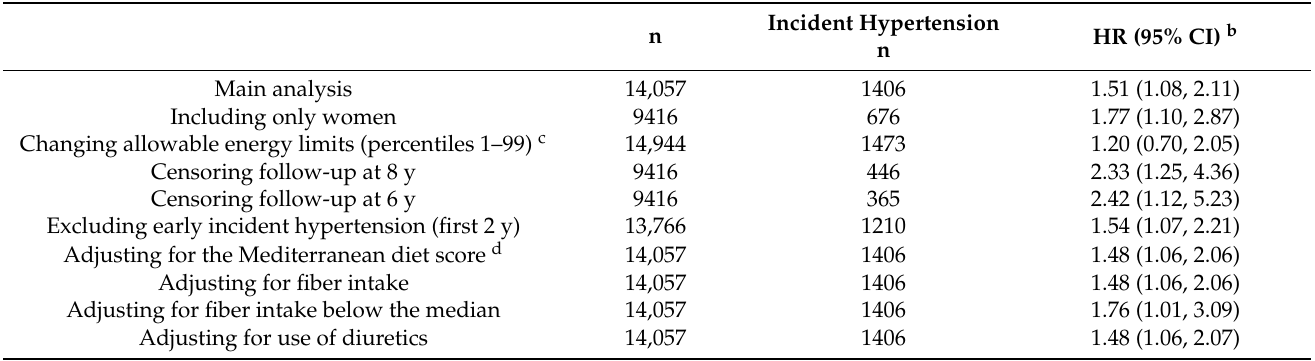
Table 4. Sensitivity analyses: multivariable-adjusted hazard ratios of incident hypertension associated with low dietary magnesium intake (<200 mg/d) among participants in the SUN Project, 1999–2016) a